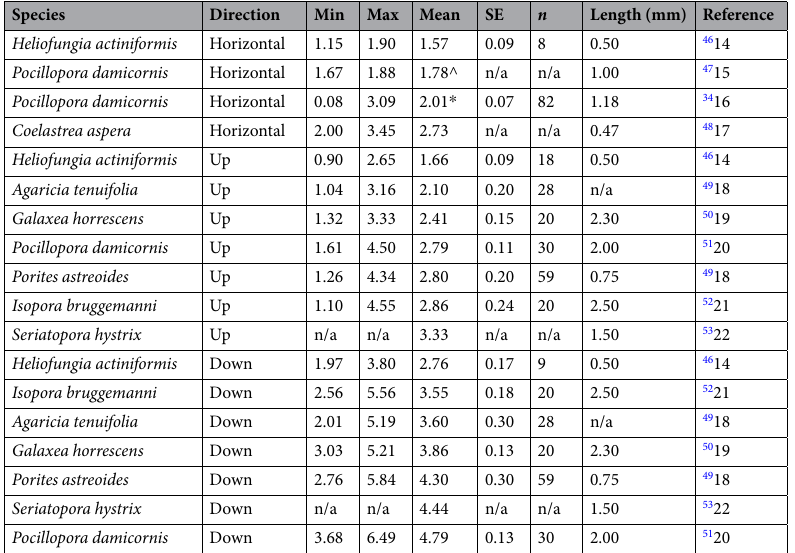
Table 1. Swimming speeds (in mm s − 1 ) for hermatypic scleractinian coral larvae. n is number of larvae; SE is standard error; ^ is the mean calculated as average of maximum (max) and minimum (min) value; * is the mean calculated from larvae aged 2 to 7 days old; n/a is not